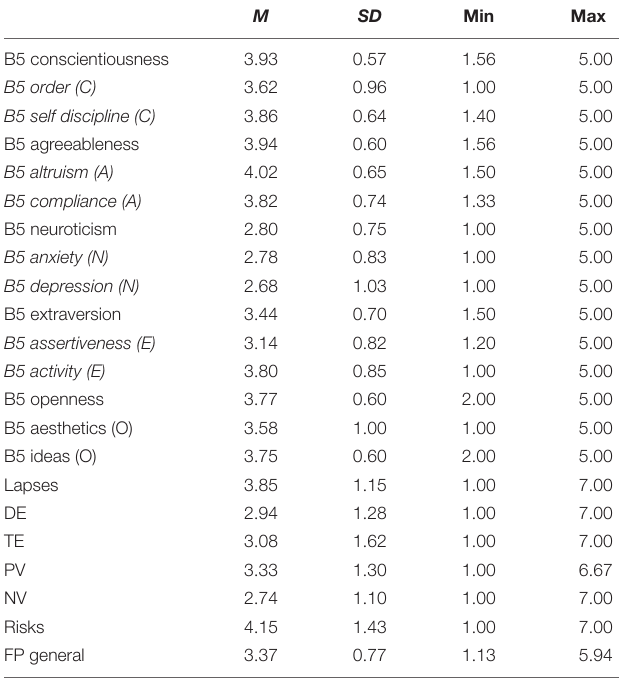
TABLE 4 | Descriptive statistics of study 2’s